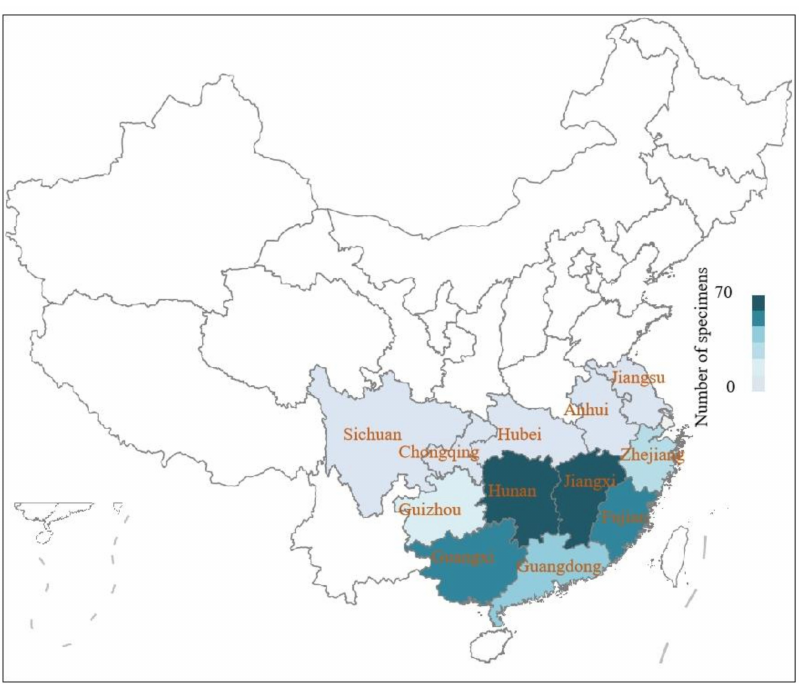
Figure 1. The geographic distribution of Stauntonia obovatifoliola subsp. urophylla . The distribution heat map was made based on the specimen data of S. obovatifoliola subsp. urophylla in a Chinese virtual